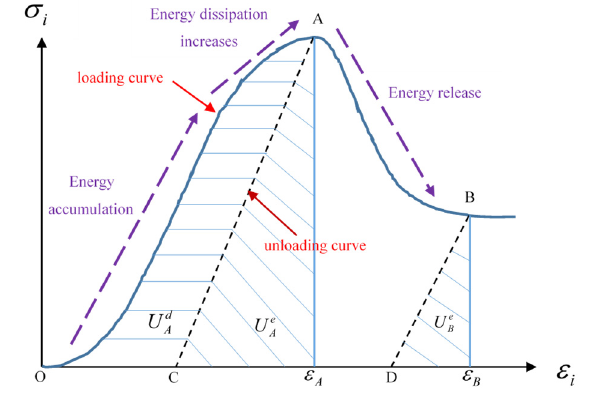
Figure 1. Complete stress-strain curve of brittle rock failure.